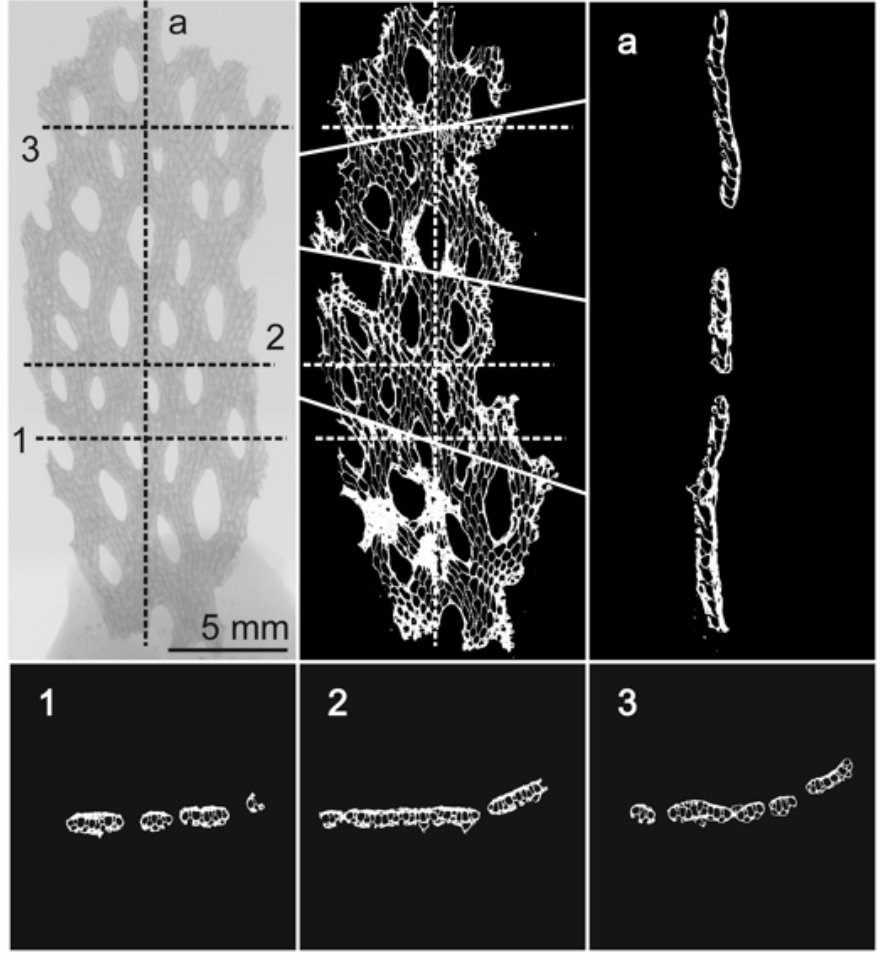
Figure 7. Micro CT images of Reteporella frigida . Radiographic image of the whole colony fragment (scale bar: 5 mm) showing the longitudinal axis ( a ) and three transverse sections ( 1 – 3 ). Scale bar micro CT images: 5 mm.